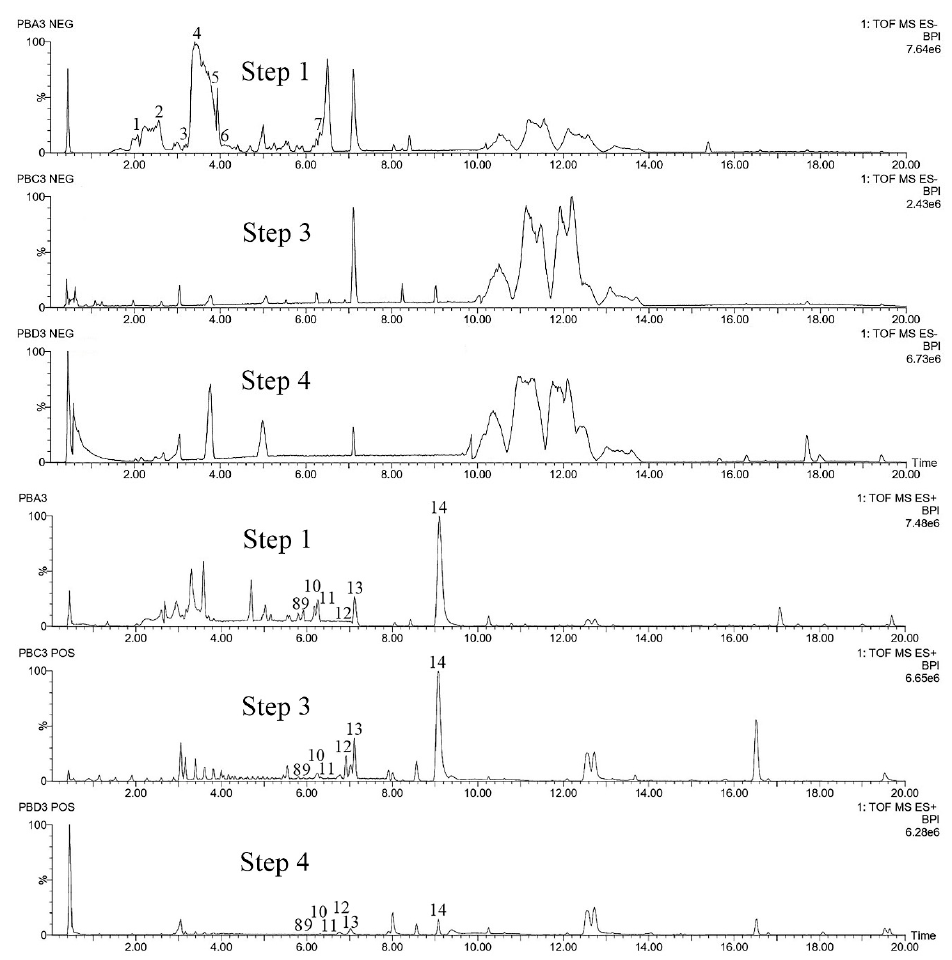
Figure 9. Base peak ion chromatograms comparing steps 1 to 4 of the leaf explants from Phyllanthus brasiliensis.